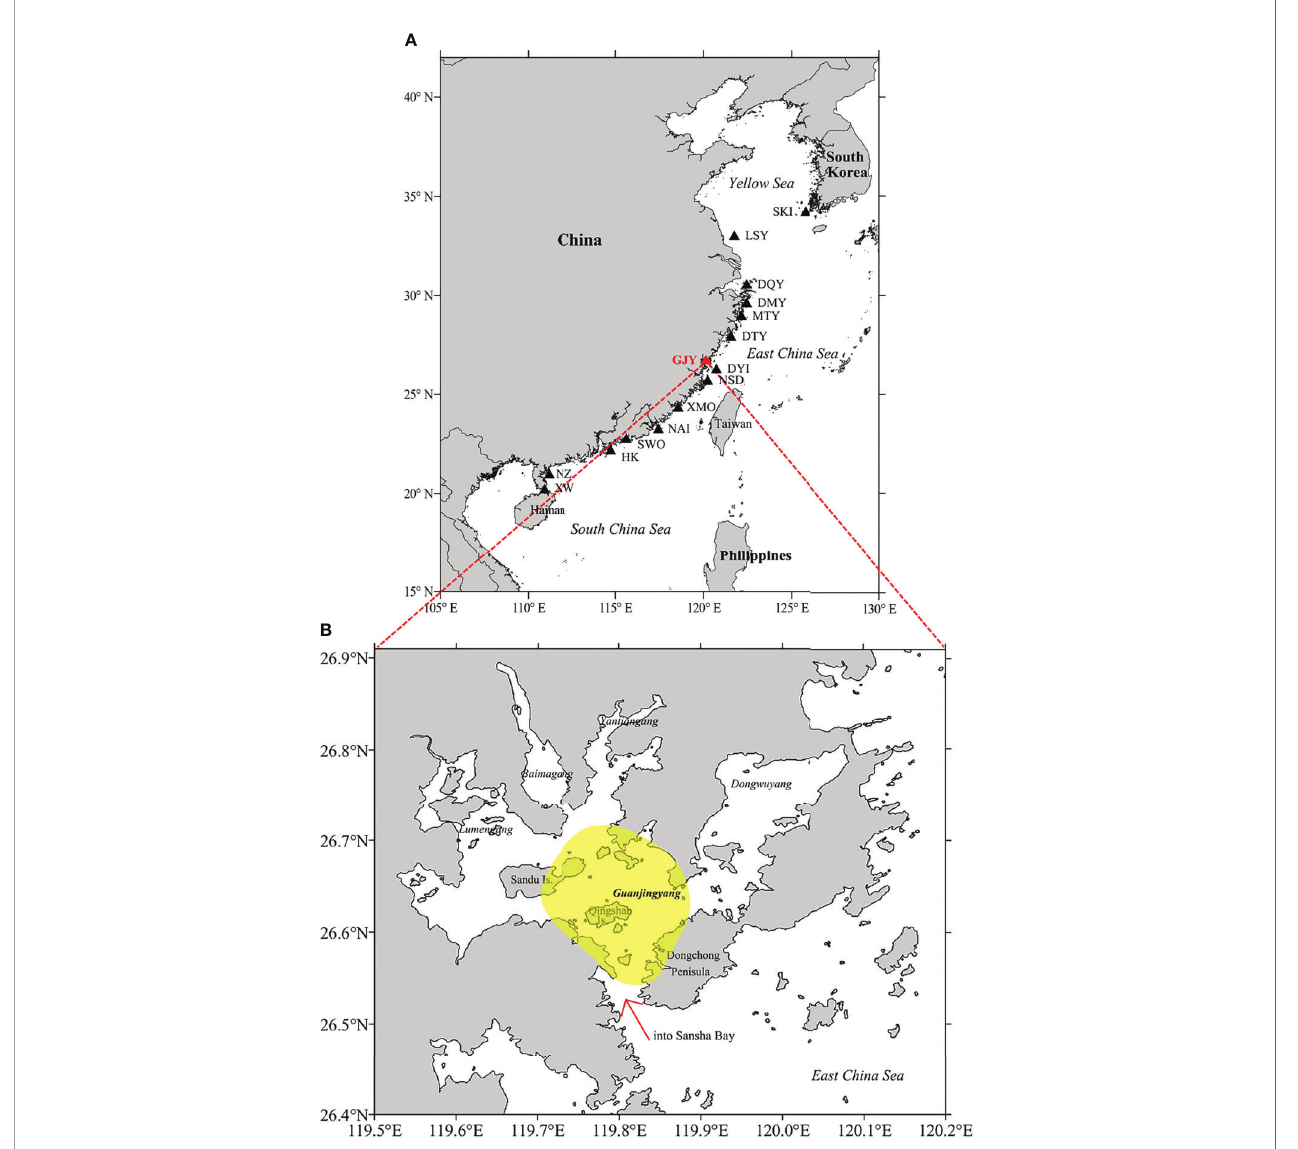
FIGURE 2 | (A) Locations of the 15 spawning grounds for Larimichthys crocea in its distribution region (SKI, South Korea-inshore; LSY, Lusiyang; DQY, Daiquyang; DMY, Damuyang; MTY, Maotouyang; DTY, Dongtouyang; GJY, Guanjingyang; DYI, Dongying Island; NSD, Niushan Island; XMO, Xiamen offshore; NAI, Nanao- inshore; SWO, Shanwei offshore; HK, Hong Kong; NZ, Naozhou; XW, Xuwen). (B) Map of Sansha Bay indicating the sampling area (yellow), Guanjingyang (GJY) waters, Fujian Province, China (red arrow shows the only entrance of Sansha